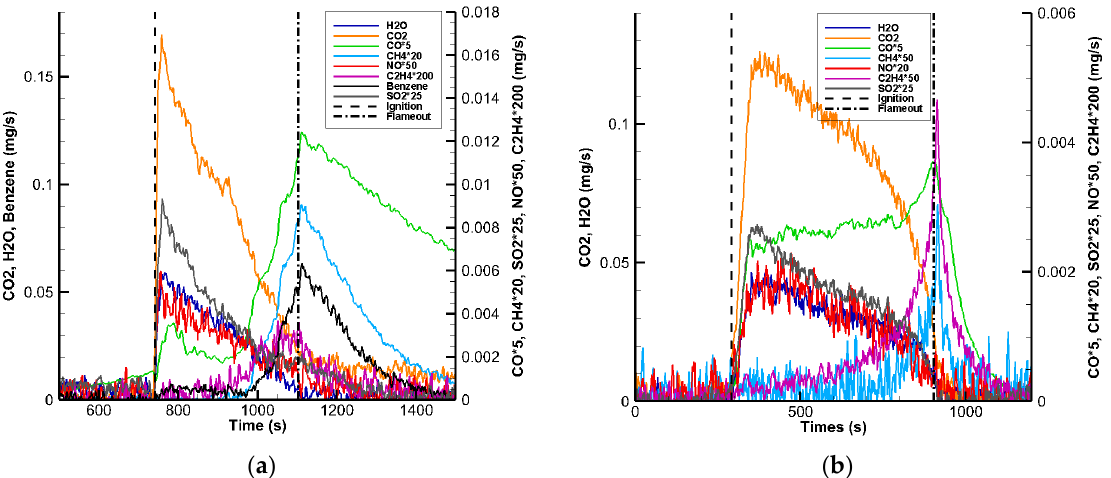
Figure 11. Mass fl ow rate of gases emi tt ed for an imposed heat fl ux of 10 kW/m2 for ( a ) wood and Figure 11. Mass flow rate of gases emitted for an imposed heat flux of 10 kW/m 2 for ( a ) wood and ( b ) thermoplastic samples. ( b ) thermoplastic